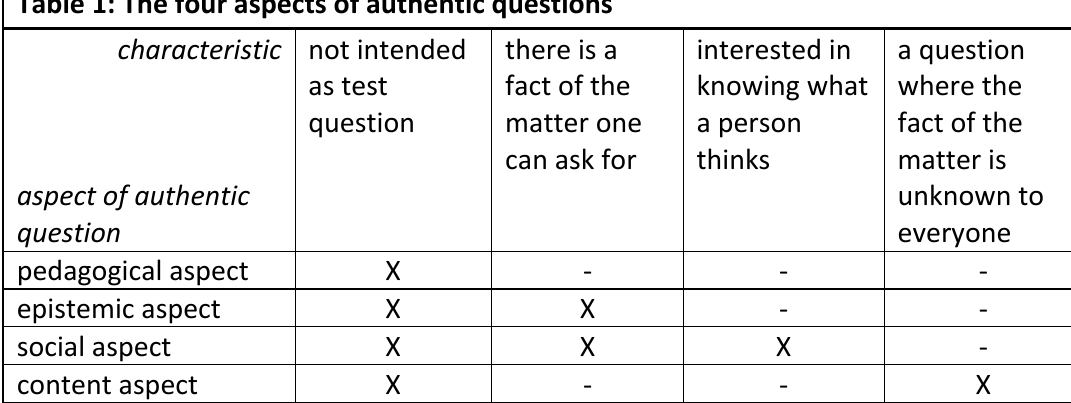
Table 1: The four aspects of authentic